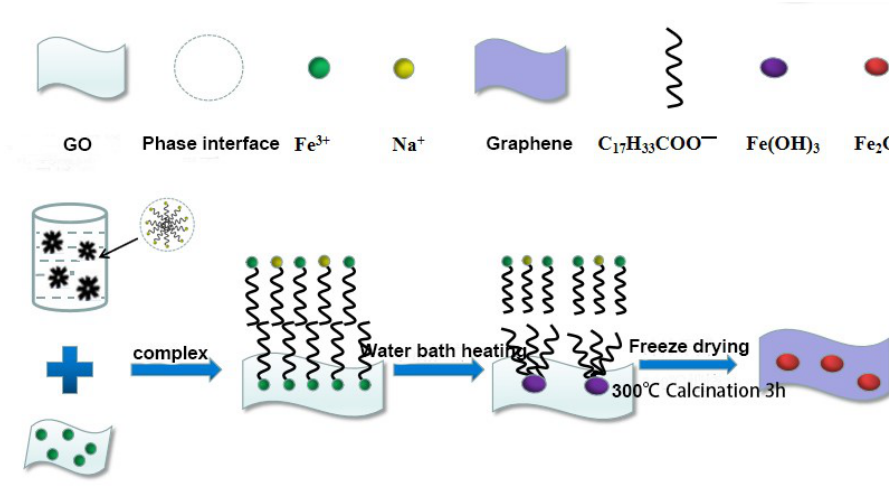
Figure 2: Schematic diagram of oleic acid assisted hydrothermal in-situ preparation of composite